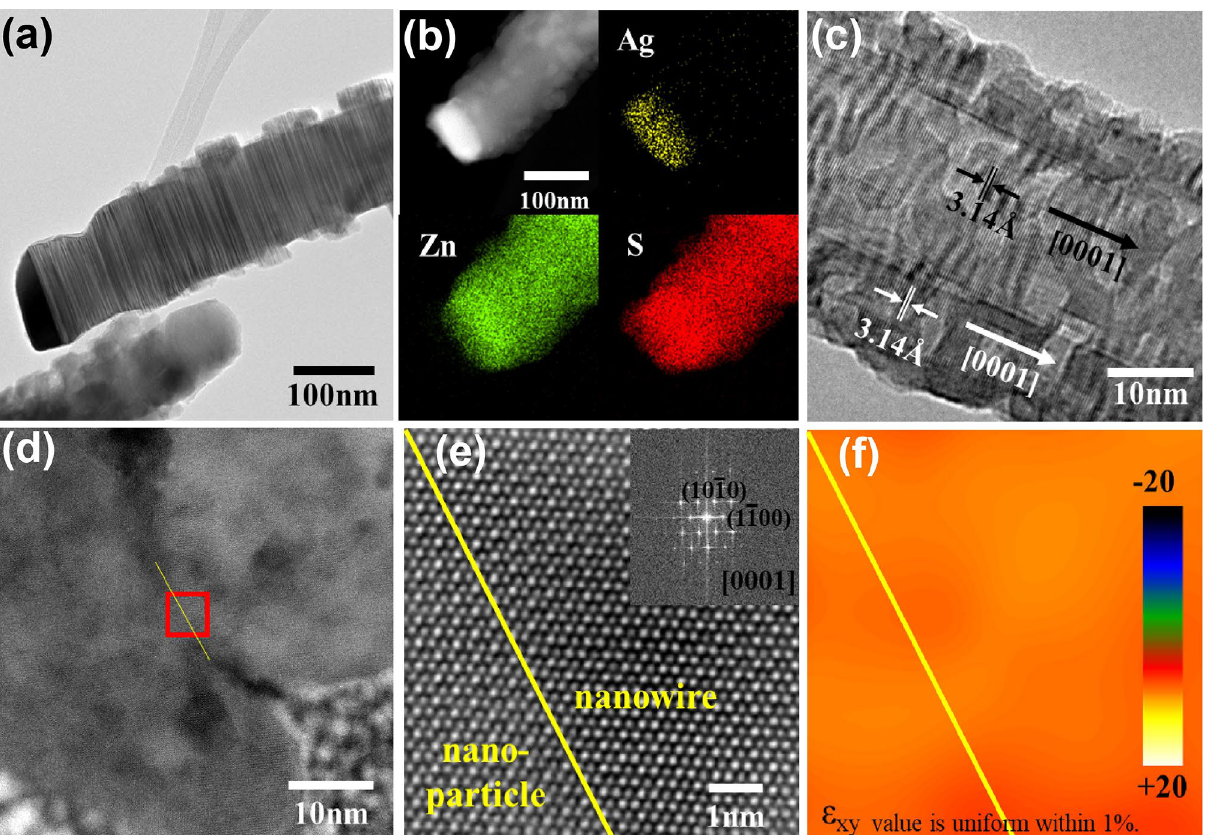
Figure 2. Structural analysis of the hierarchically-assembled ZnS nanostructures. ( a ) A BF TEM image of hierarchically-assembled ZnS nanostructure. ( b ) HR ADF-STEM images of the nanostructure and EDS element maps (yellow: Ag, green: Zn, red: S). ( c ) HR-TEM image of a single ZnS nanostructure showing the c-axis growth and single-crystalline nature. ( d ) BF TEM and ( e ) HR ADF-STEM images obtained from a cross-section of hierarchically-assembled ZnS nanostructures (inset: corresponding FFT pattern). ( f ) The strain field of ( e ) that was calculated by using